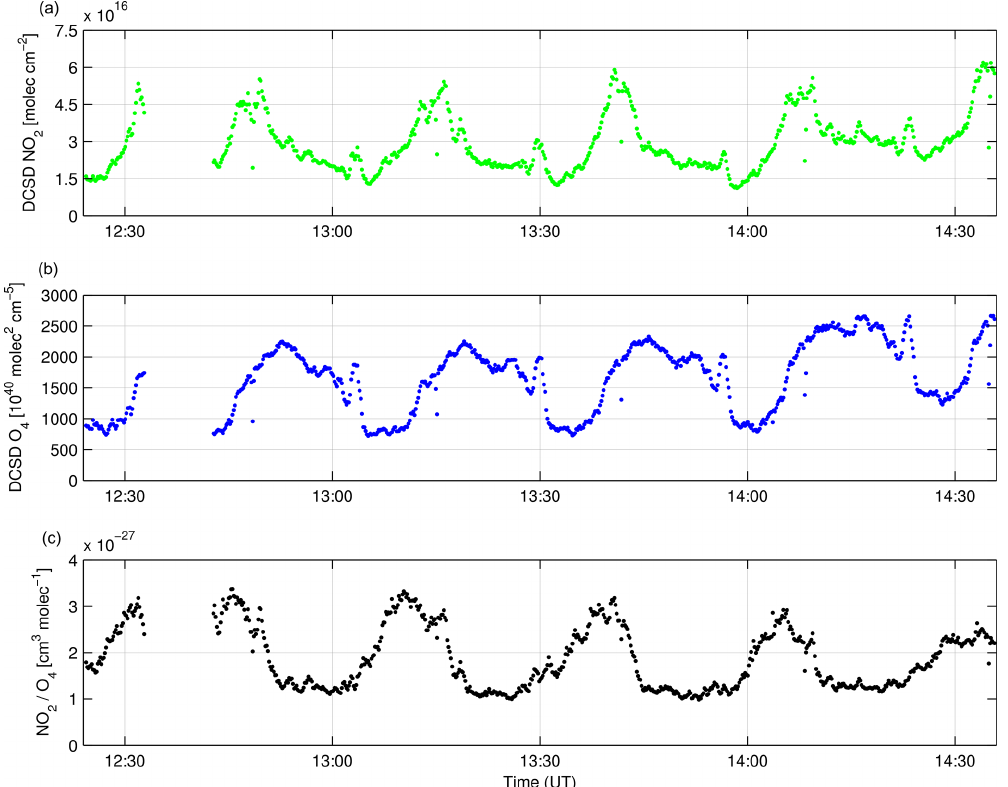
Figure 12. Time series of NO 2 (a) and O 4 (b) DSCDs as obtained from the tower DOAS off-axis measurements performed on 22 April 2016. The ratio of NO 2 / O 4 is shown in (c)